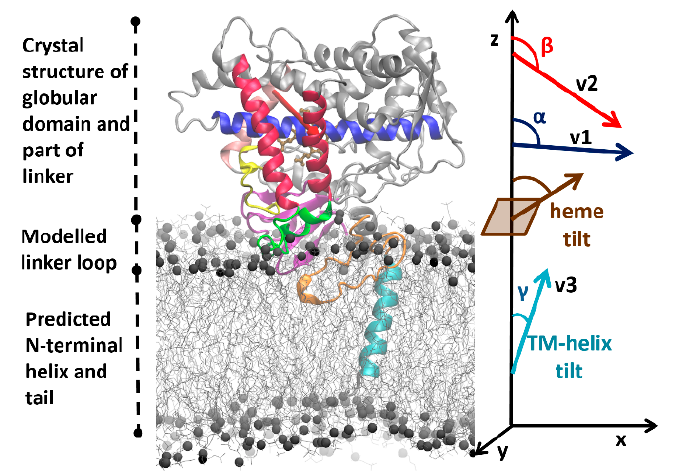
Figure 2. Initial model of human cytochrome P450 (CYP) 2C9 showing its three domains and the initial information on which modeling and simulation of its arrangement in the phospholipid bilayer was based. The crystal structure (PDB 1R9O) of the globular domain (residues 50–490) and part of the linker region (residues 37–49) are shown in cartoon representation. Secondary structure predictions indicate the length of the N-terminal transmembrane (TM)-helix (cyan, residues 3–21). These two components are connected by a modeled linker loop of unknown conformation (orange, residues 22–36). The flexible C-terminal tail (residues 491–492) was not included in the model. The F’–G’ helices (residues 210–220) were not observed in the structure and were modeled from the crystal structure of CYP 2C19 (PDB 4GQS). Important secondary structure elements in the globular domain are colored as follows: β -strand region in magenta, F and G helices in red, I-helix in blue, B–C loop in yellow, and F’–G’ helices in green. The heme is shown in brown stick representation. Experimentally, it is known that the globular domain interacts with the bilayer (shown in grey line representation with grey spheres representing the phosphorous atoms) and, during the coarse-grained (CG) simulations, it approached and dipped into the bilayer. The heme tilt angle and the angles α and β defining its orientation in the bilayer are shown on the right, along with the definition of the TM-helix tilt angle ( γ ), and the vectors (v1 along the I-helix , v2 shown by the red arrow from the C to the F helix, and v3 along the TM-helix) computed to define these angles; the definitions of these angles are given in the Materials and Methods section.